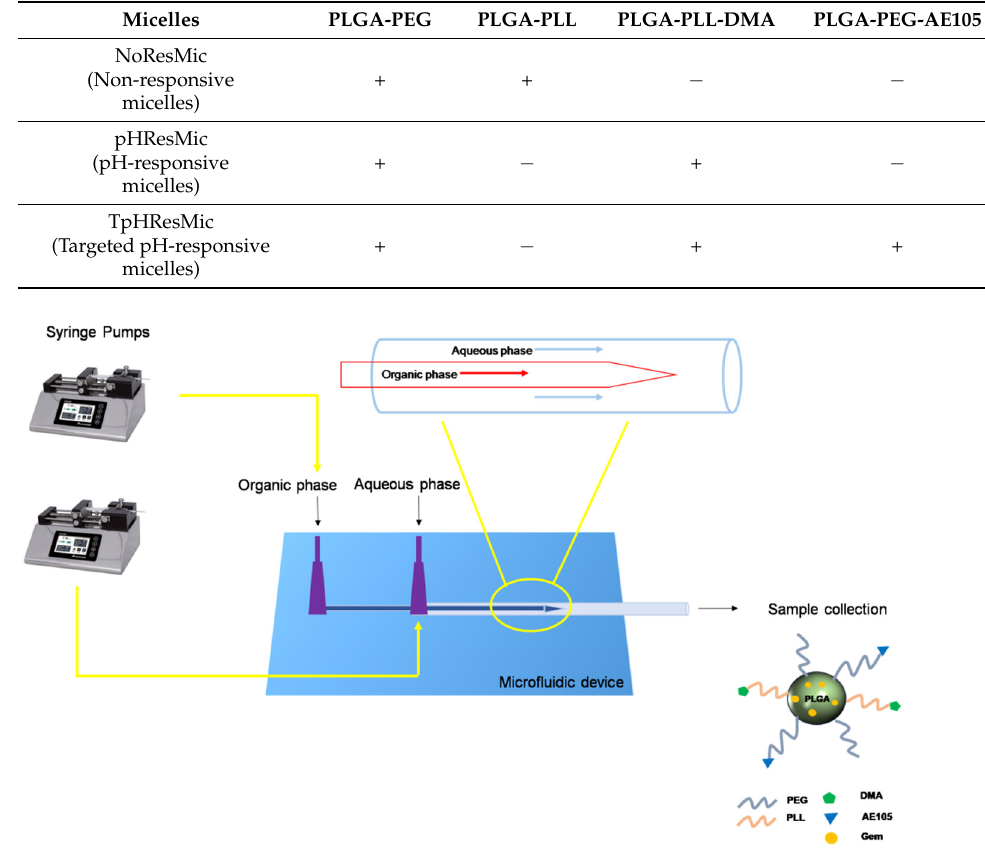
Figure 1. Schematic representation of the microfluidic platform for the production of micelles.